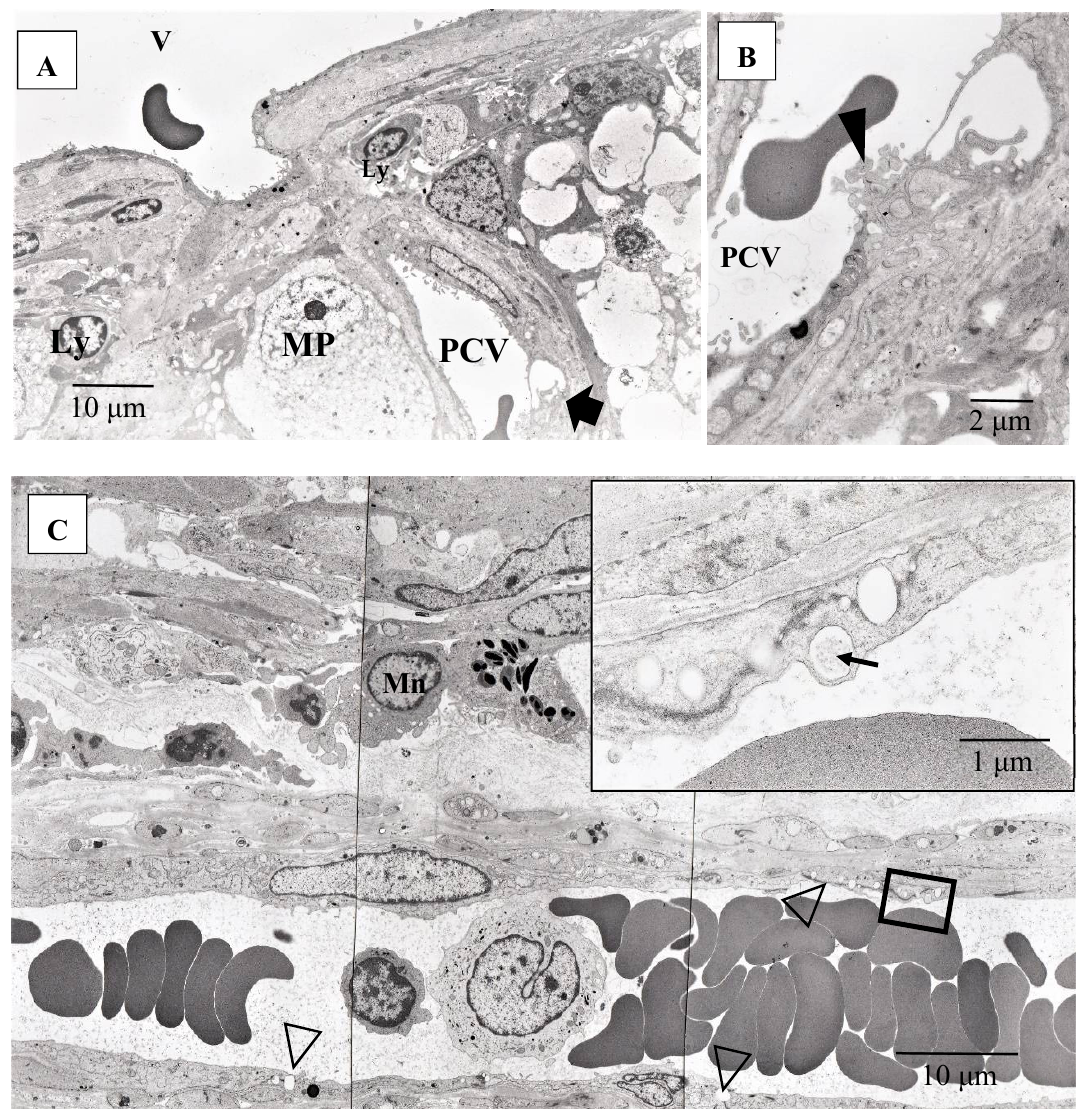
Figure 14. ( A – C ) Transmission electron microscopy photographs of retinal blood vessels in tangential sections ( A – C ) of the left eye of Autopsy Case 1, a 75-year-old female. Samples of the retina were taken from the area of the radial peripapillary capillaries ( A , B; large magnification of the area pointed by arrow in A ) and the periphery ( C ). Macrophage (MP) surrounding the postcapillary venule (PCV) and endothelium of the PCV was infiltrated by inflammatory cells (arrowhead in B ). The endothelium of the retinal blood vessel had many vacuoles (inset in C ) along the junctional areas (arrowheads in C ). Some of the vacuoles contained fibrillar materials (arrow in C , inset). Ly: lymphocytes, Mn: monocytes, V: retinal vein.